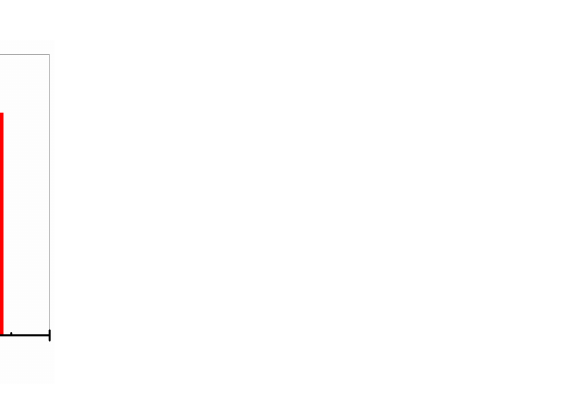
Figure 9. The low-frequency impedance modulus at 0.01 Hz obtained in LiOH-H 3 BO 3 solution after 1 h and 48 h immersion for different samples: (1) pure Ni layer; (2) Ni/nano-TiC